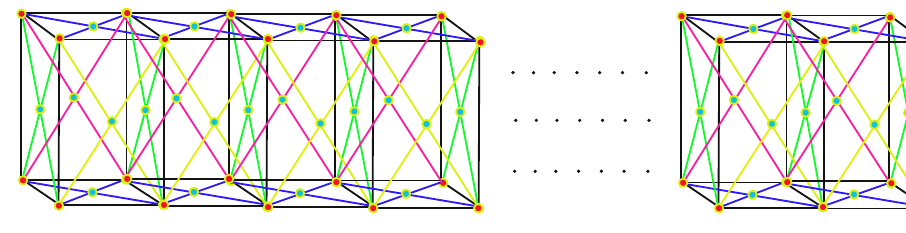
Figure 2. Face-centered cubic lattice FCC ( n ) . Table 1. Degree-based partition of edges of face-centered cubic lattice FCC ( n )